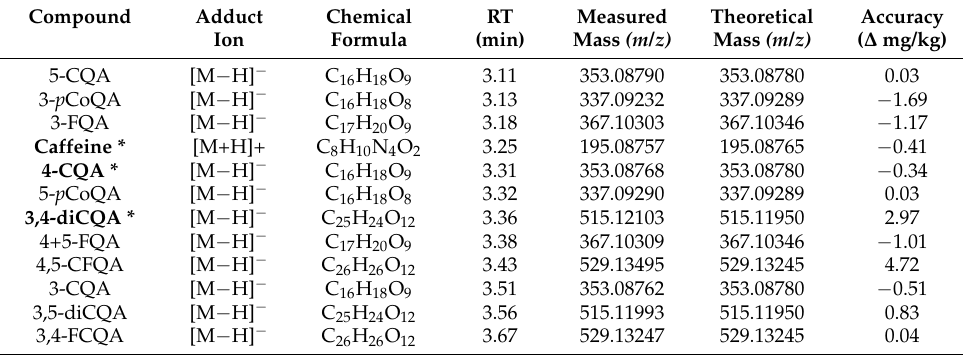
Table 1. UHPLC-MS parameters of the investigated analytes ( n =